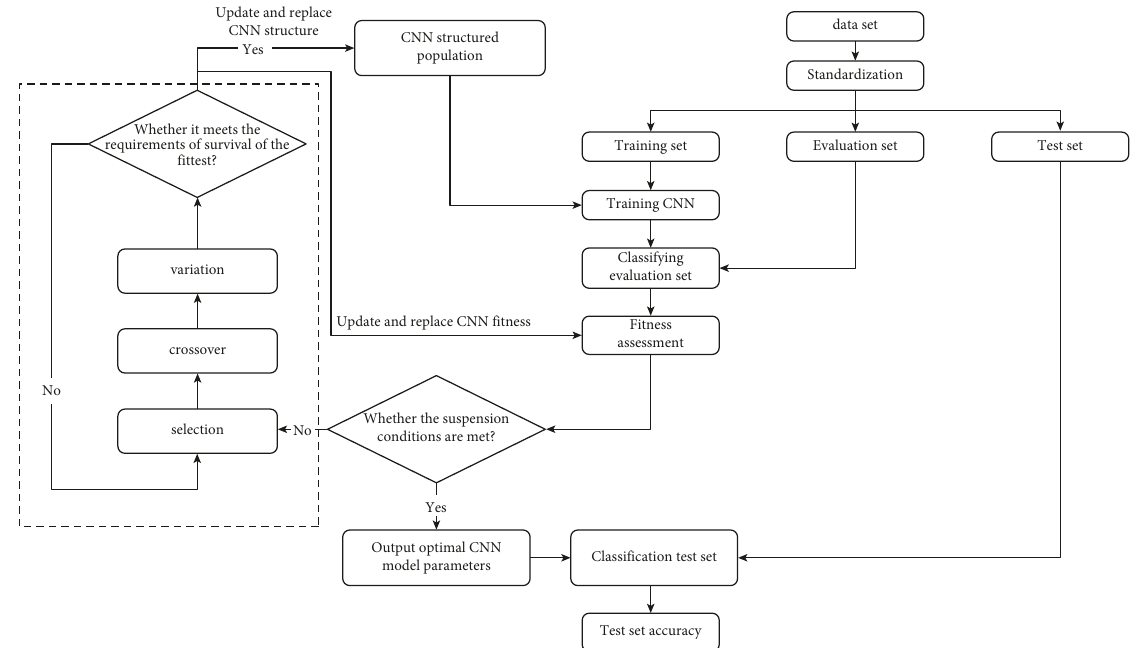
Figure 3: System architecture of GA-CNN algorithm.